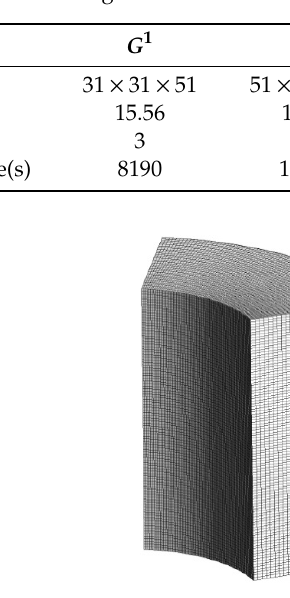
Table 2. Di ff erent grid size used to check the grid independence test.